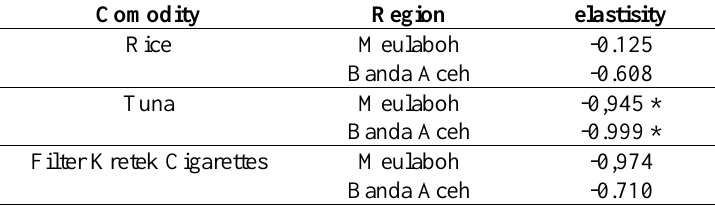
Table 4 Elasticity Komditas Food (by Marshallian)